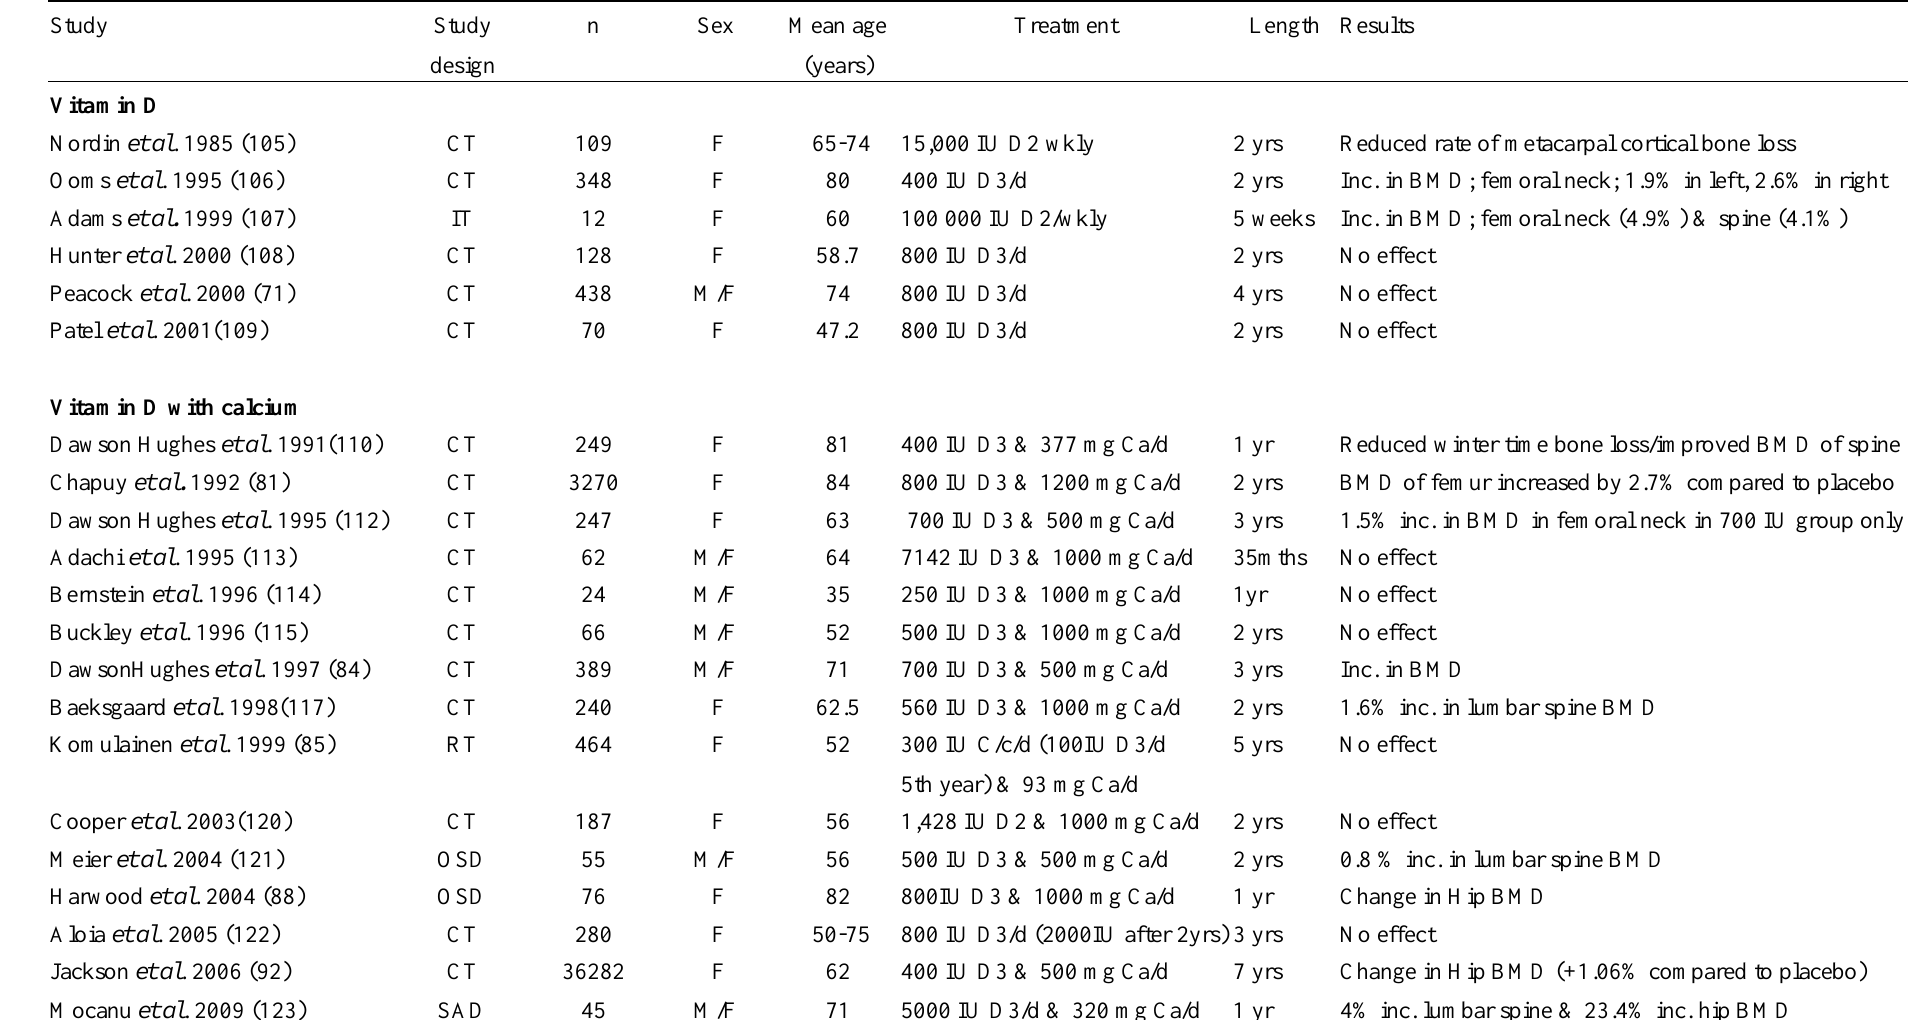
Table 4. Intervention with vitamin D (with / without calcium) on bone mineral density